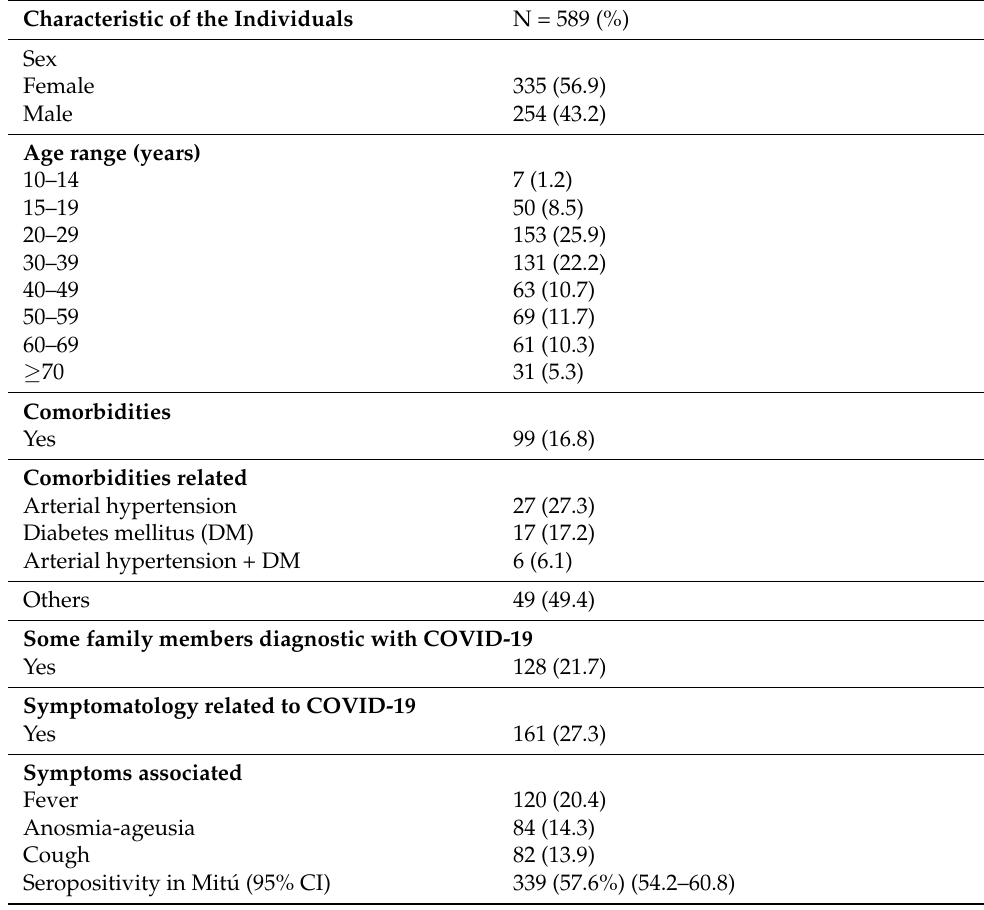
Table 1. Description of the sociodemographic and clinical characteristics of the study participants. Characteristic of the